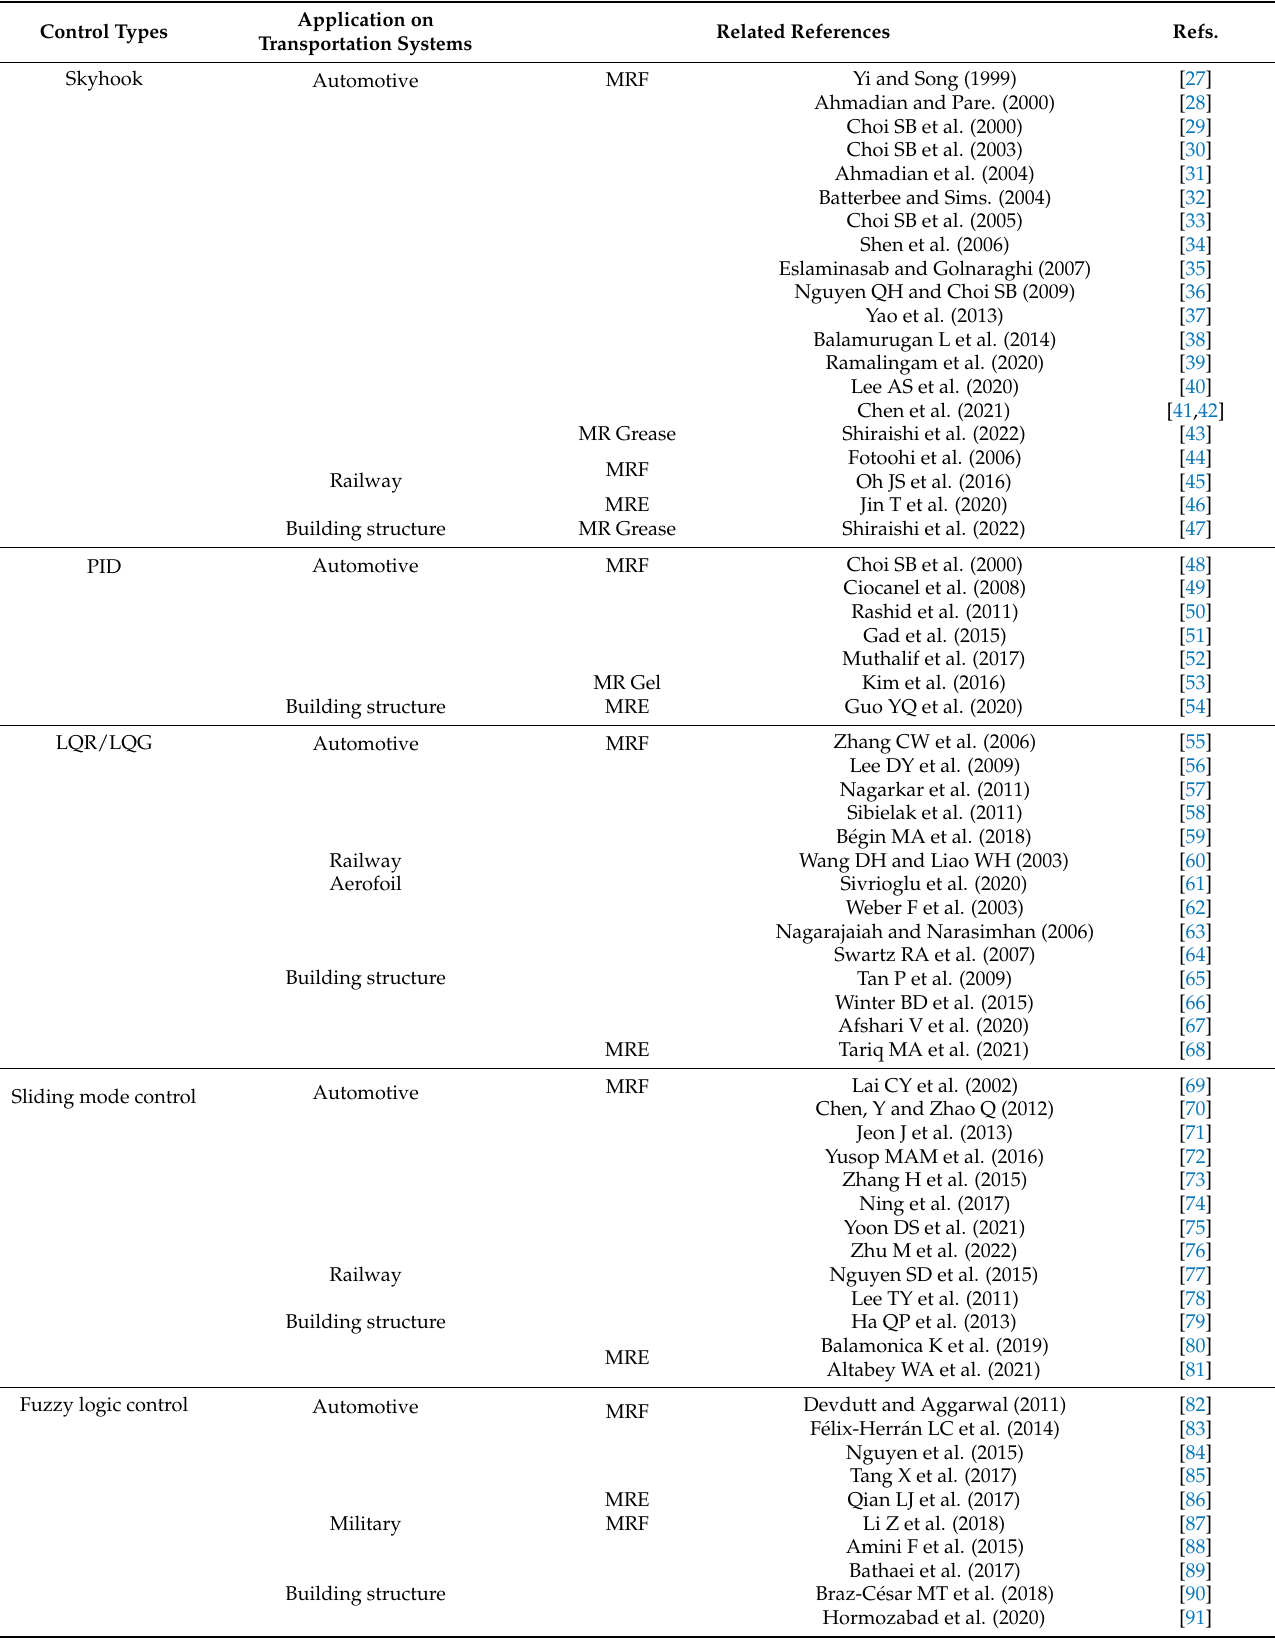
Table 1. Vibration control strategies using magnetorheological materials actuators: application